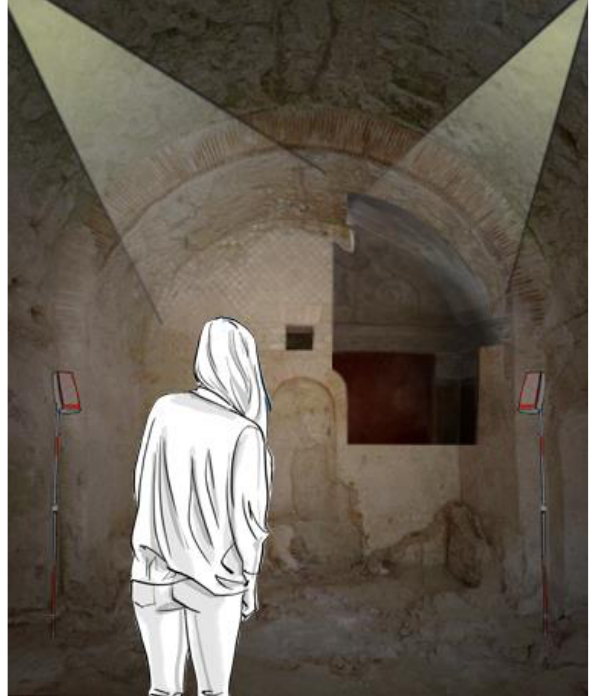
Figure 13. Example of “additioned” screening. The use